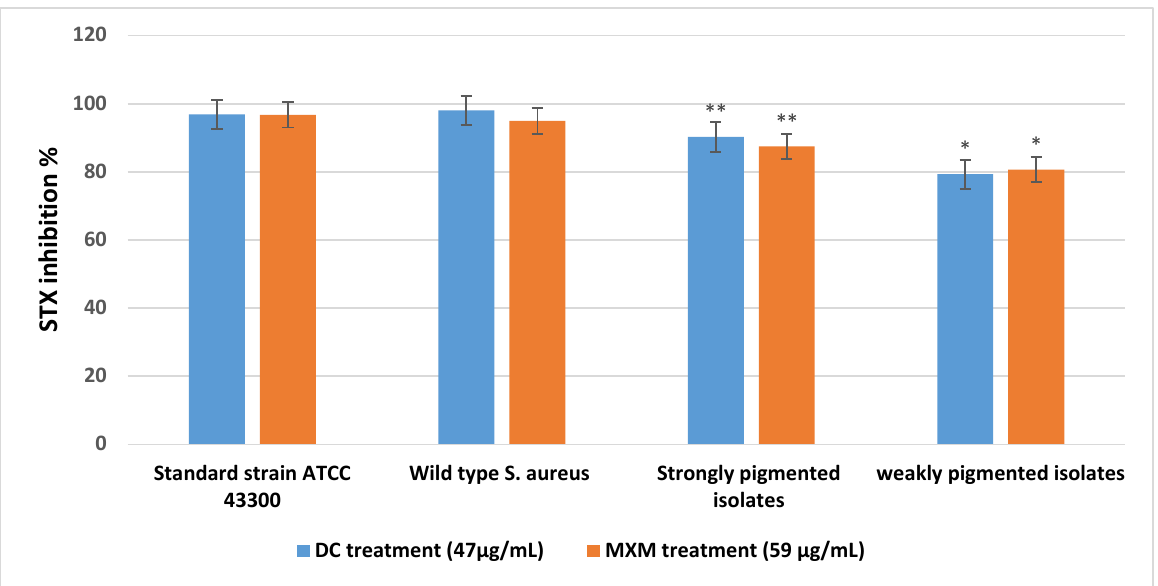
Figure 4. Mean and standard deviation values for STX inhibition percentage of strongly and weakly pigmented isolates in comparison with the standard strain and wild type S. aureus. ** represents higher statistical significance difference among strongly pigmented isolates than weakly pigmented isolates (*) with both drugs at p ≤ 0.05.